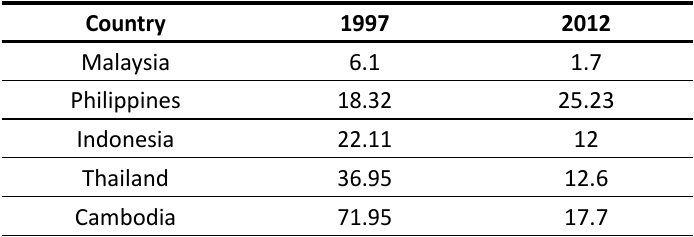
Source: World Bank (2015),